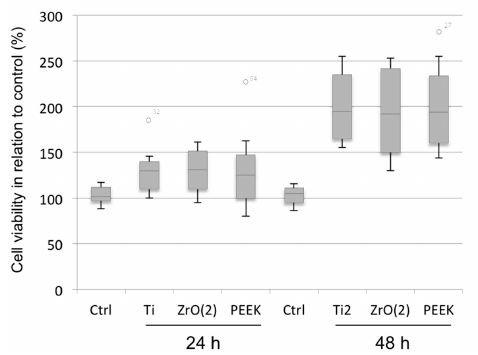
Figure 1. Cell viability assay analysis (MTT) of HGEK 24 h and 48 h compared the control (acrylic polystyrene), titanium (Ti), zirconia [ZrO( 2 )] and PEEK (PEEK) discs. X-axis = points of measurement, Y-axis = OD (optical density).